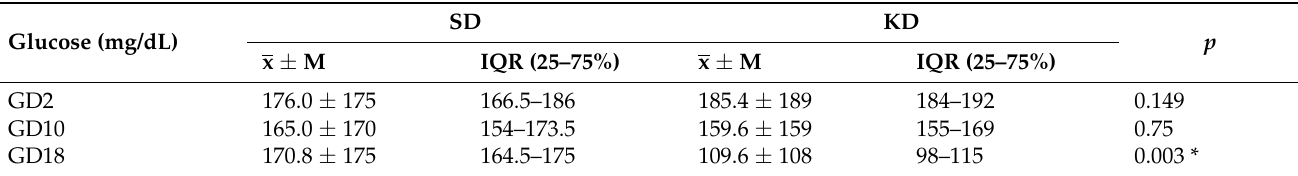
Table 3. Maternal blood glucose